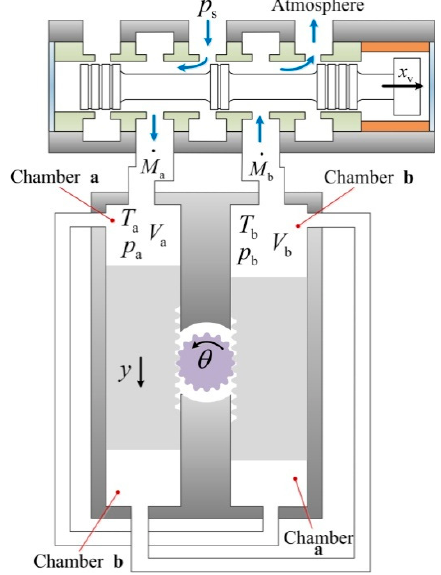
Figure 2. Gas flow mechanism in the valve-controlled actuator system.